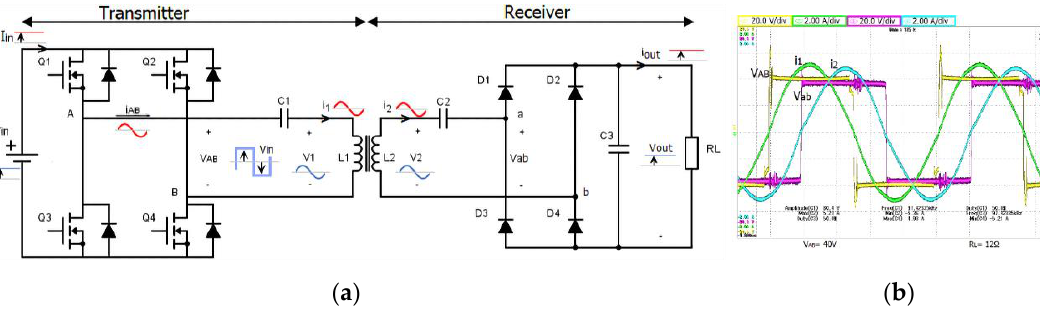
Figure 10. Block diagram of the wireless power transfer system for the e-bike.